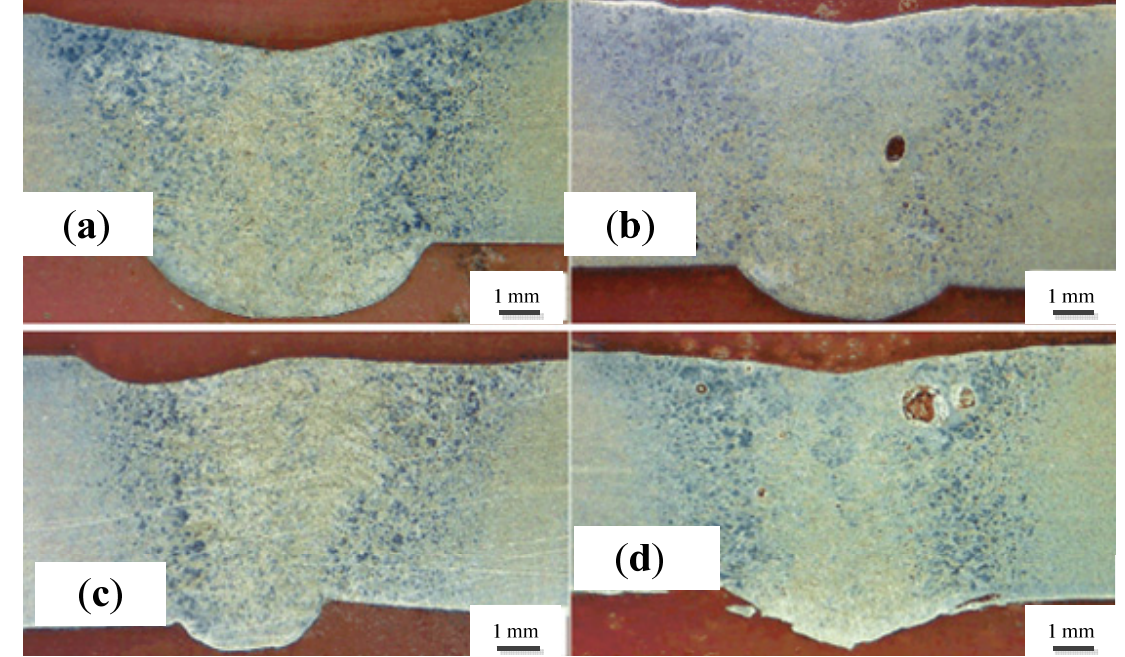
Figure 10. The cross-section morphology under different welding speed: ( a ) 8 mm/s, ( b ) 9 mm/s, ( c ) 10 mm/s, ( d ) 11 mm/s.